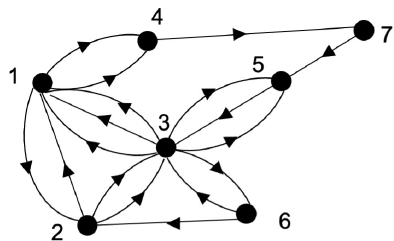
Figure 6. An example of multidigraph 𝐺 with seven vertices.